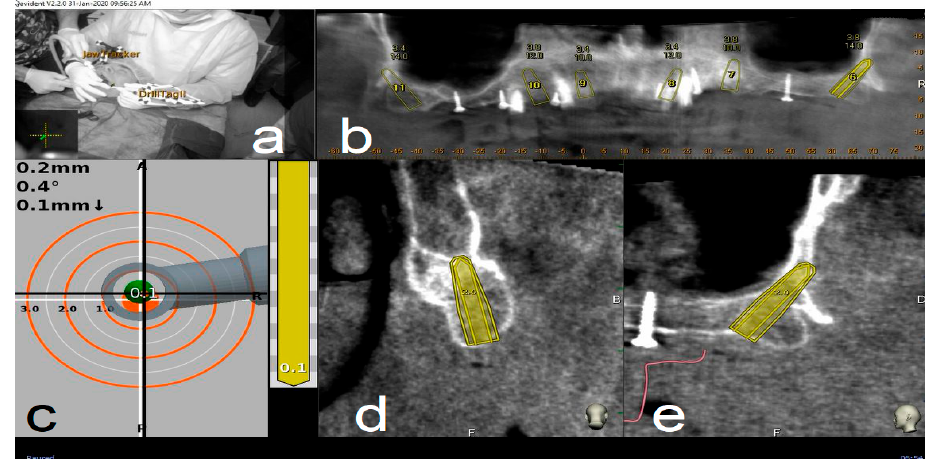
Figure 5. Clockwise from up left. The figure indicates the several views on the screen during surgery: tracker video stream ( a ), panoramic view ( b ), target view and depth indicator ( c ), bucco-lingual section view ( d ), and mesio-distal section view ( e ).